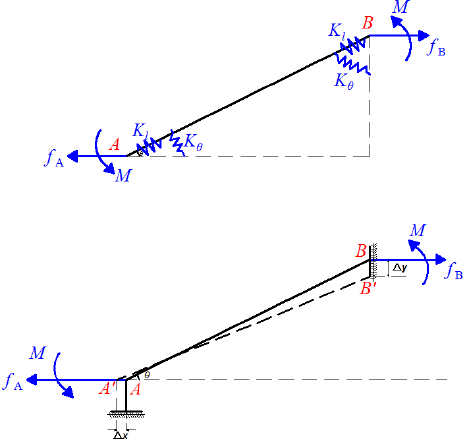
Figure 8. Force diagram of one arm of the diamond amplifier.